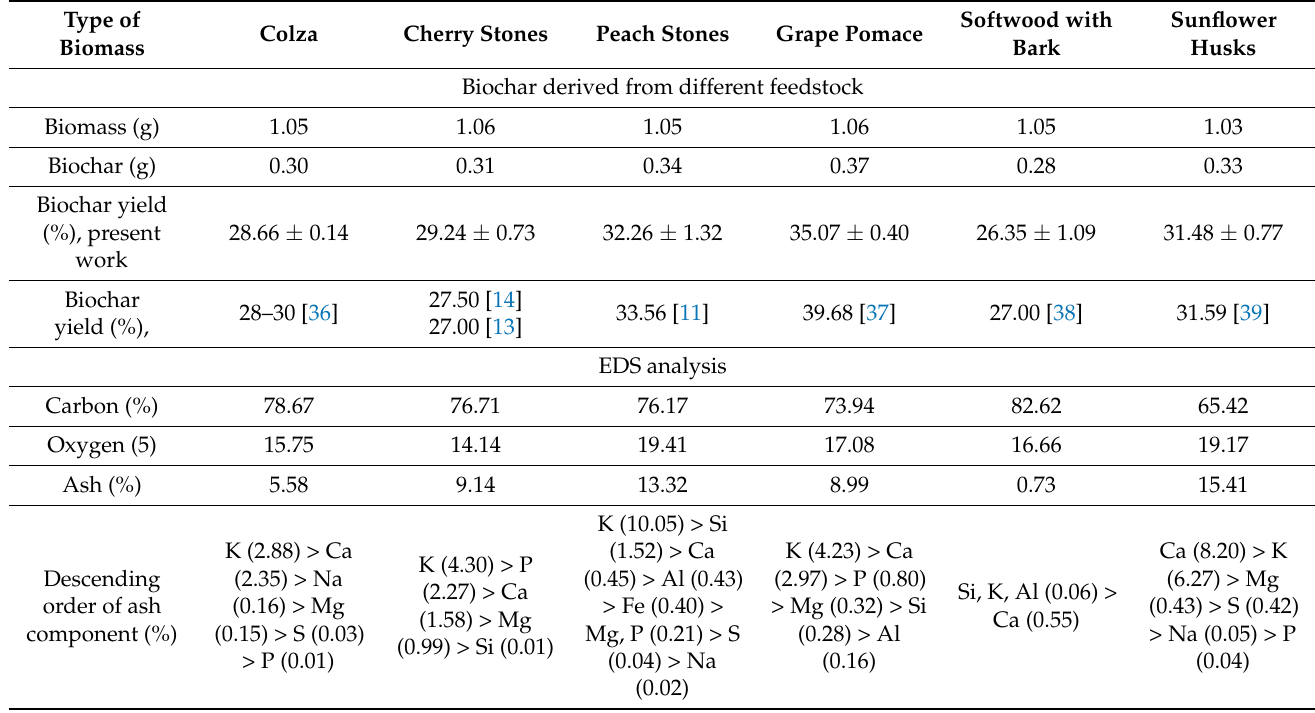
Table 2. Yield and EDS analysis of biochar derived from different